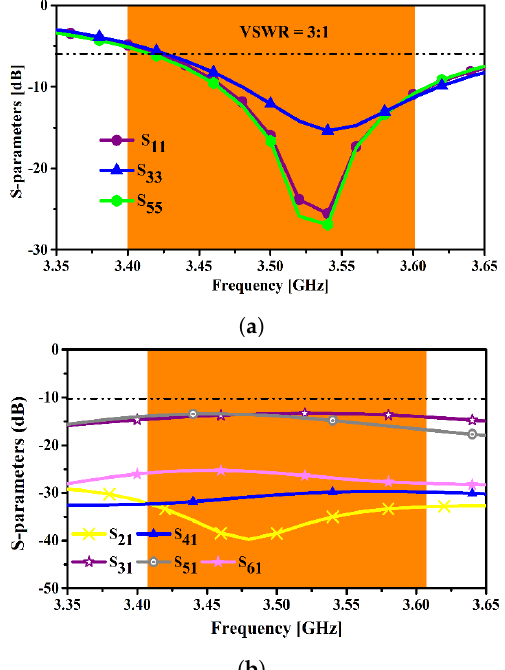
Figure 15. Simulated S-Parameters ( a ) Impedance Bandwidth, ( b ) Ports